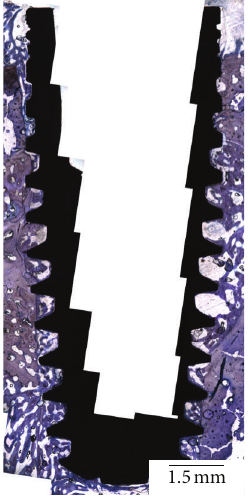
Figure 3: No morphologic differences were observed between implants placed with either conventional or simplified techniques. The evaluation of the histologic sections at all time points showed direct contact between implant and bone in cortical and trabecular regions, as showed in this section of a 4.2 mm diameter implant at 5 weeks of